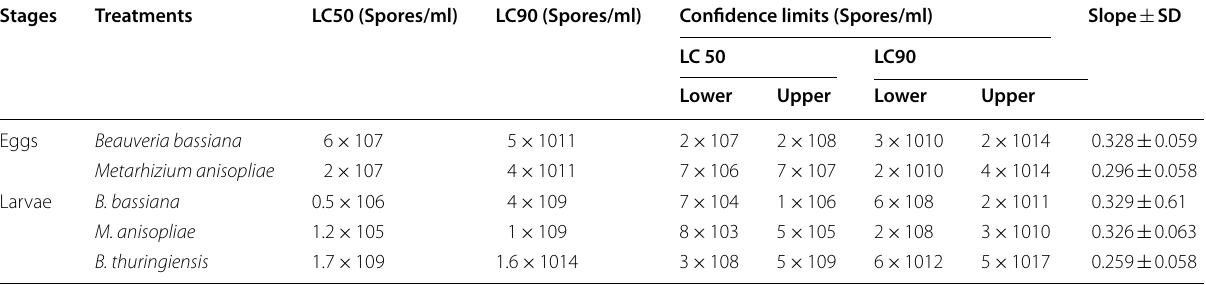
Table 3 LC and LC values with their confidence limits for eggs and larvae of Ephestia cautella treated with three entomopathogens 50 90 at 14 days after Beauveria bassiana and Metarhizium anisopliae treatments and after 5 days for Bacillus thuringiensis treatments